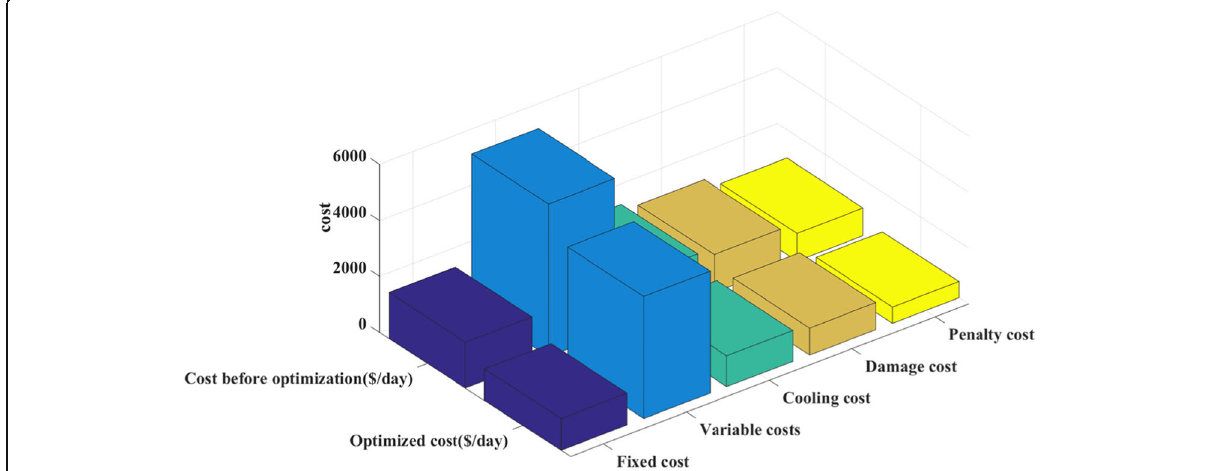
Fig. 4 Comparison of optimization